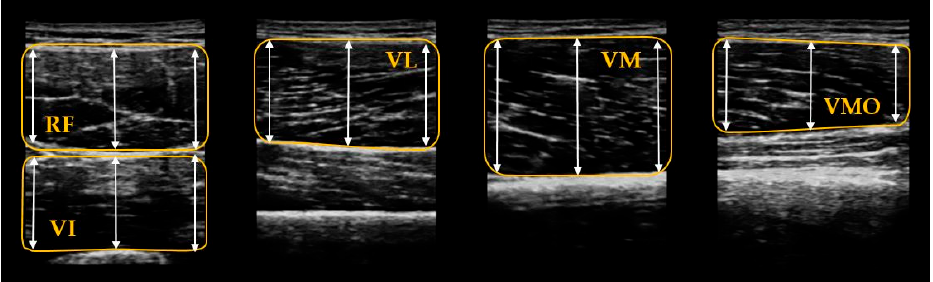
Figure 4. Image of the thickness of the quadriceps muscles. RF: rectus femoris; VI: vastus intermedius; VL: vastus lateralis; VM: vastus medialis; VMO: vastus medialis oblique.